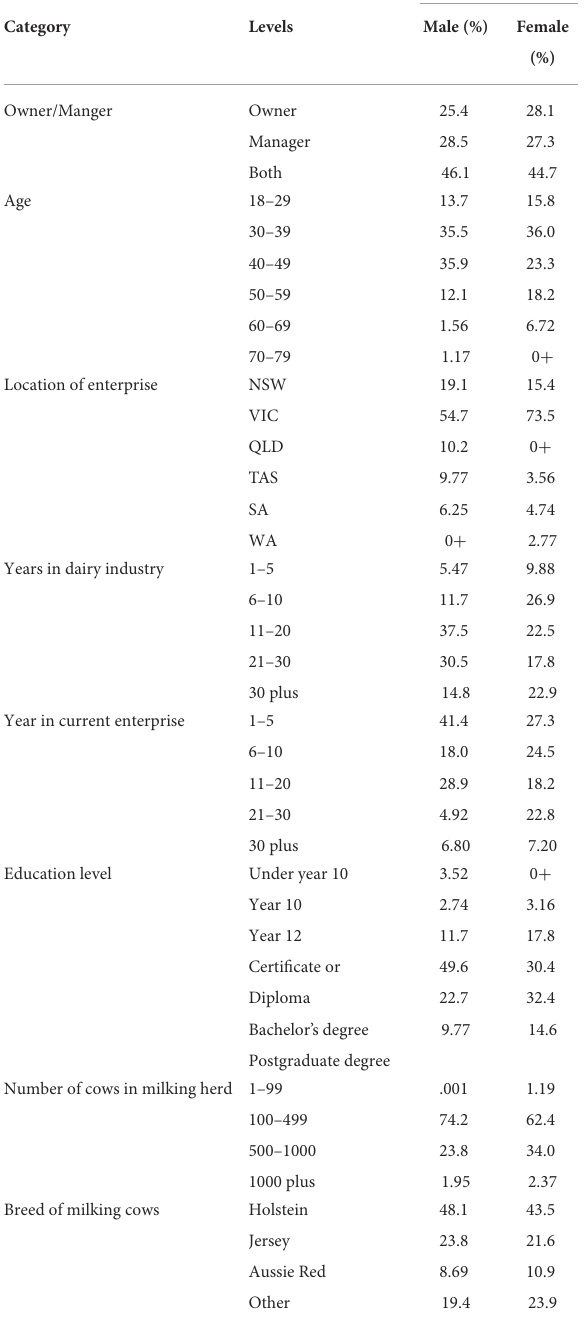
TABLE 1 Percentages reported for demographic responses of Australian dairy producers in the Bayesian network model when different levels for gender (male and female) were selected as the target